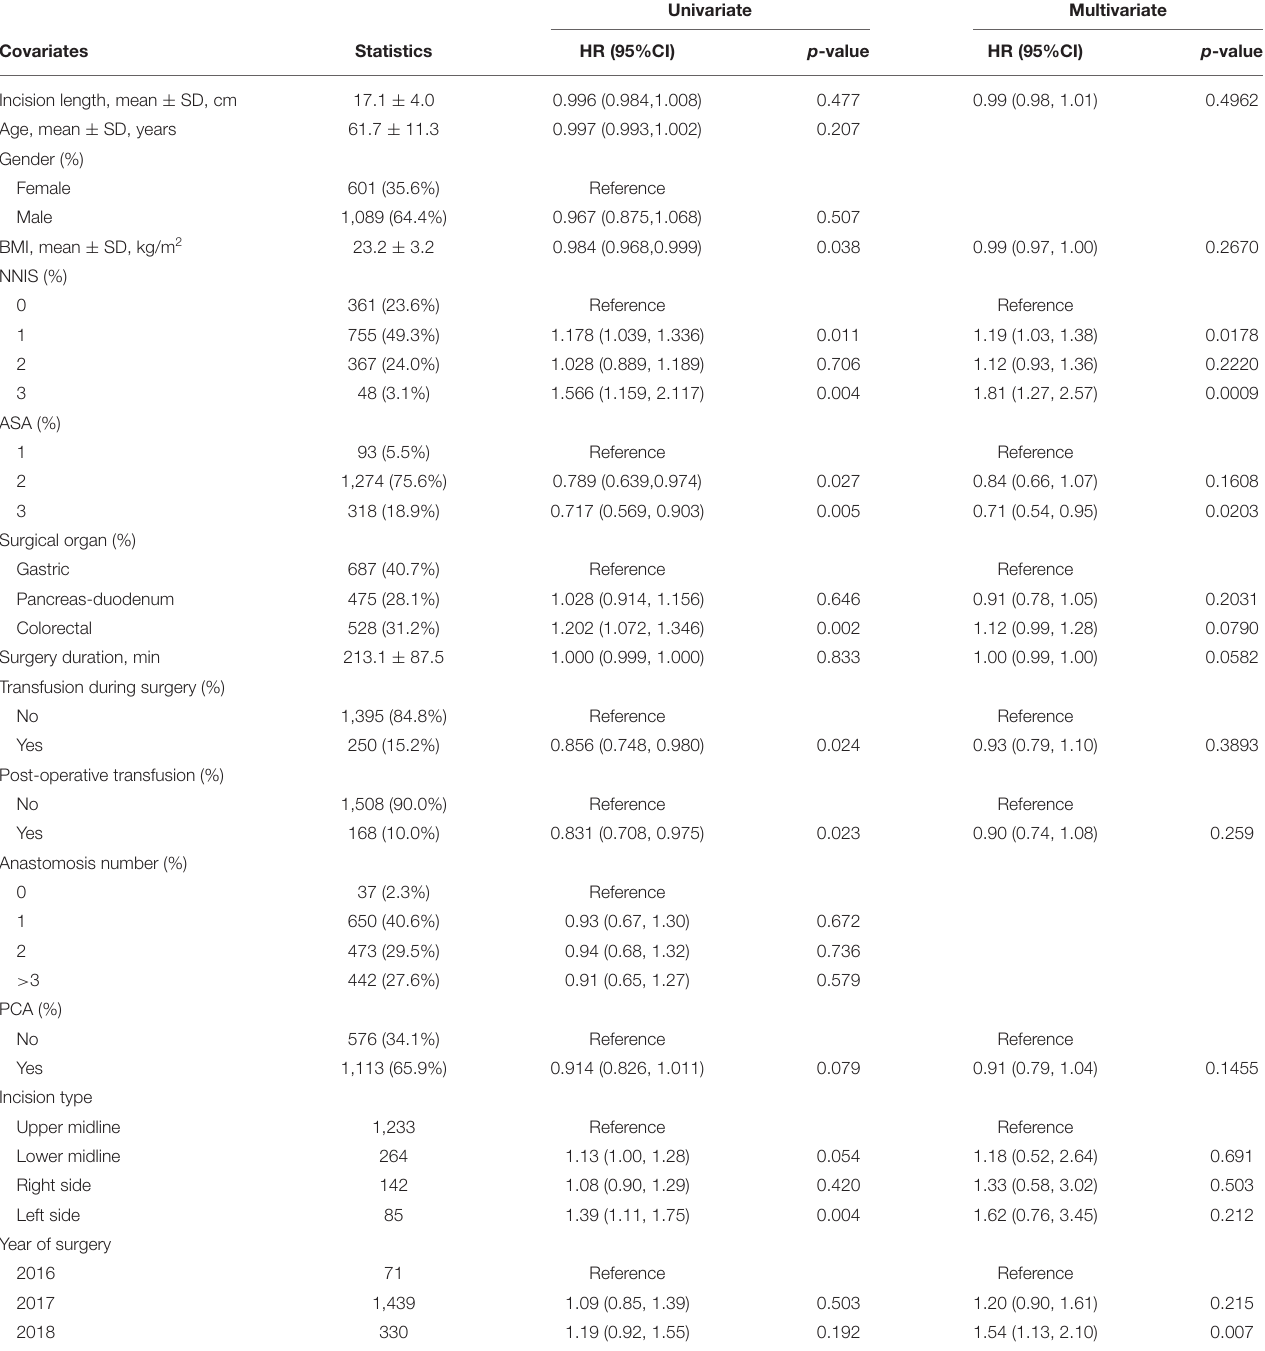
Univariate Multivariate